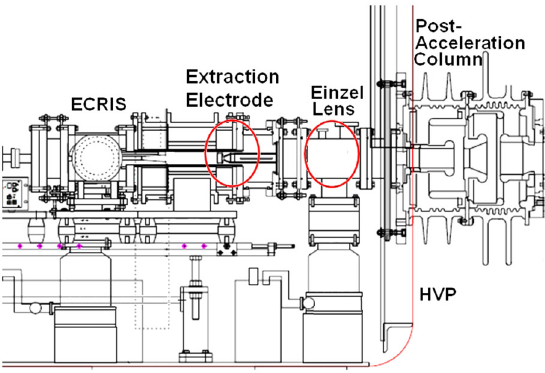
FIG. 4. Possible candidates for a longitudinal chopper.